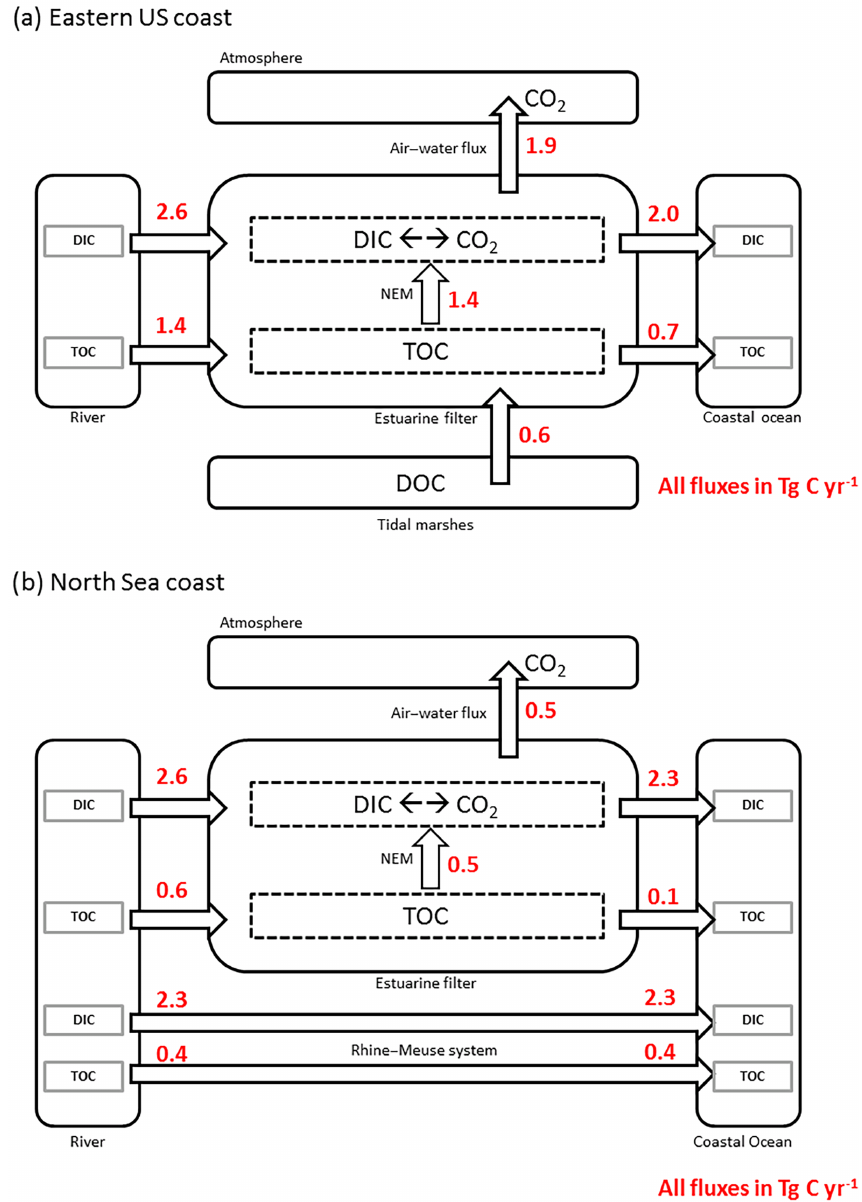
Figure 11. Annual carbon budget of the estuaries of the US East Coast (a) and of the coast of the North Sea ( b ; modified from Volta et al.,